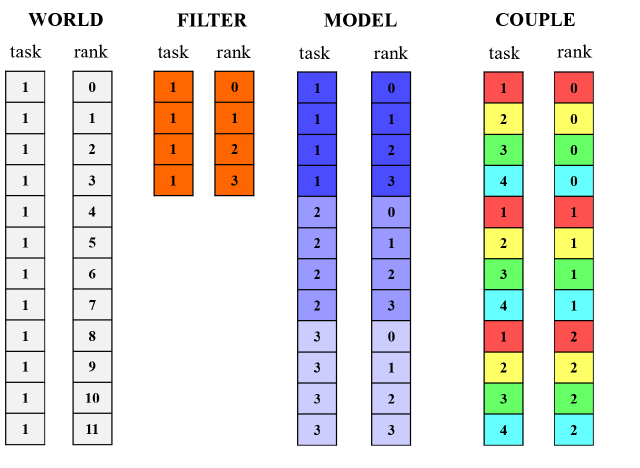
Figure 2. Example of the processor layout of the